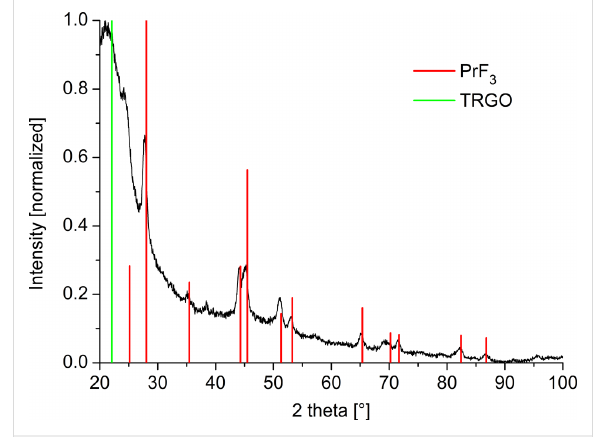
Figure 1: Example PXRD of 0.5 wt % PrF 3 @TRGO-SH in [BMIm][BF 4 ] synthesized from [Pr(AMD) 3 ]. PrF 3 reference reflections in red from COD 1010984. For the diffractogram with indexed reflections see Figure S18 in Supporting Information File 1. The PXRDs for the other samples are given in Figures S4–S19 in Supporting Information File